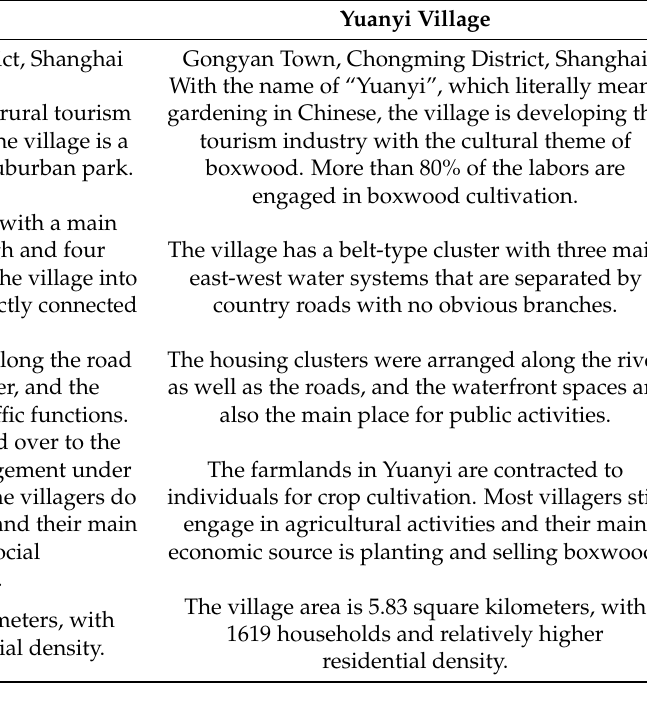
Table 1. Comparison of Puxiu and Yuanyi